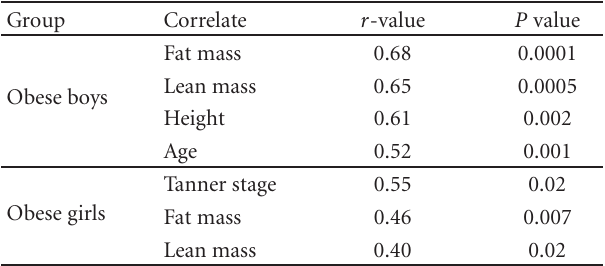
Table 4: Univariable correlations with